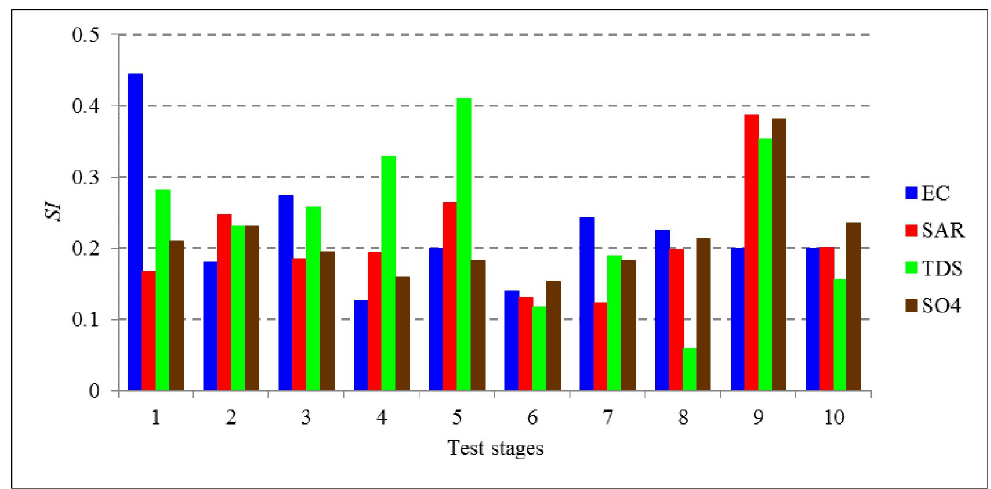
Fig 10. SI variations of the SVM-FFA model among the test stages (second